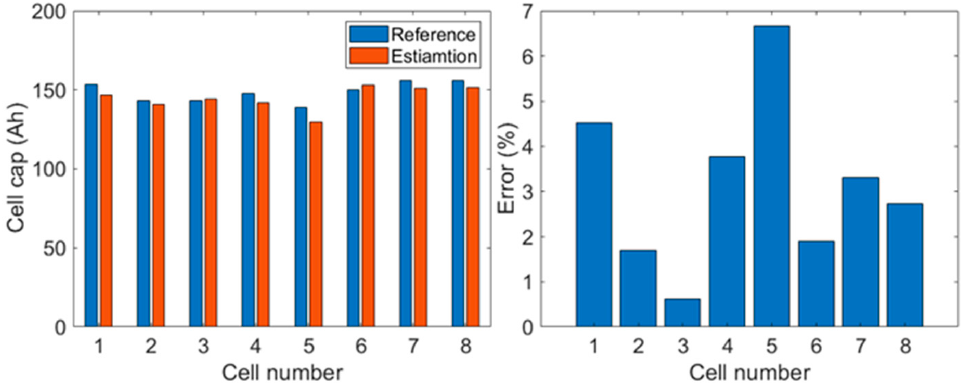
Figure 18. Estimation results and estimation error with mechanism-based method (aged data).